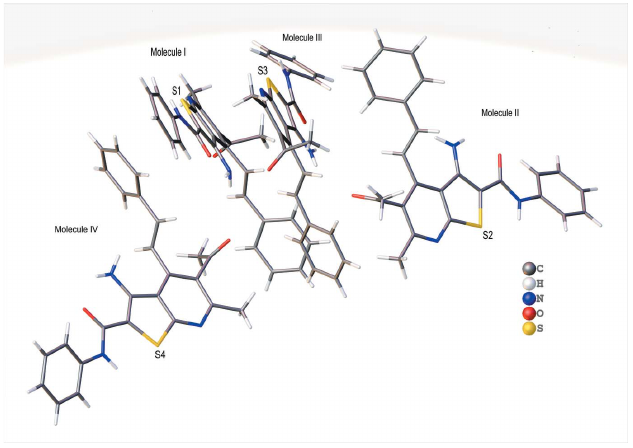
Figure 1 The four molecules (I, II, III and IV) in the asymmetric unit of ( I